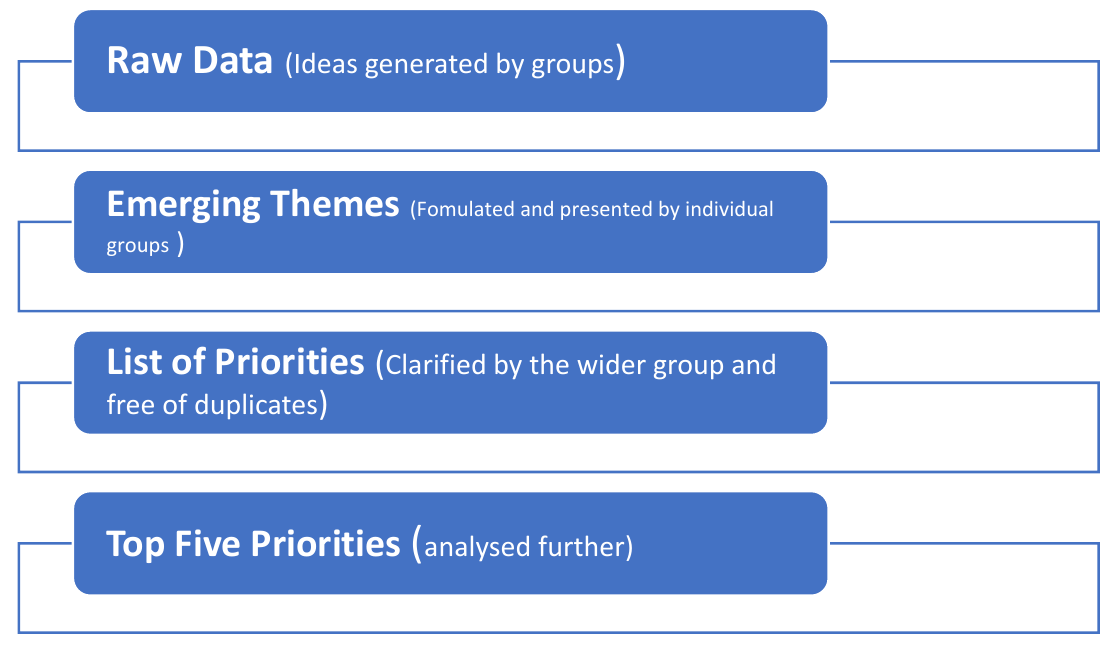
Figure 2. Overview of the NGT Data analysis Process .